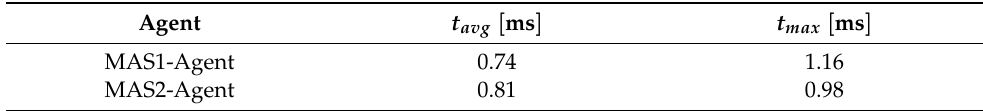
Table 4. Run time of agents of MAS1 and